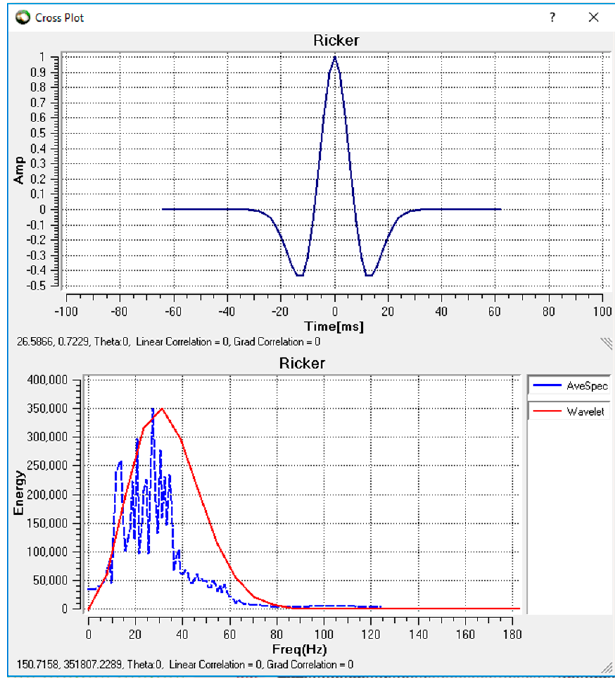
Figure 11. The plots of the extracted wavelet (Time-Amplitude, Frequency-Power, Frequency-Phase) for correlation between seismic and well log in time and frequency at 2000–2300 ms.